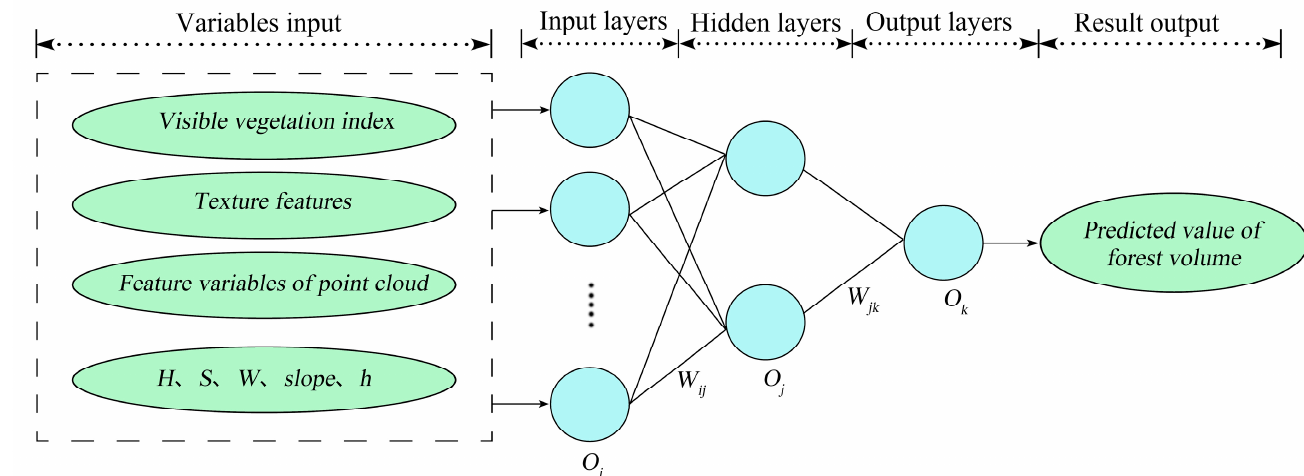
Figure 6. Structure model of artificial neural network. O i represents input neurals, O j represents hidden neurals. O k represents output neurals. Shown are the input neuron O i , and each input to the hidden layer neuron O j is interconnected by selected weights. Then, the weighted output is combined and input into the output neuron O k to form the output value.